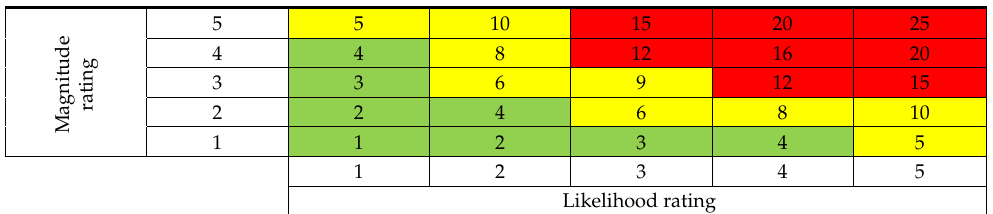
Table 3. Magnitude/likelihood matrix and risk level. Red, high risk; yellow, medium risk; green, low risk.